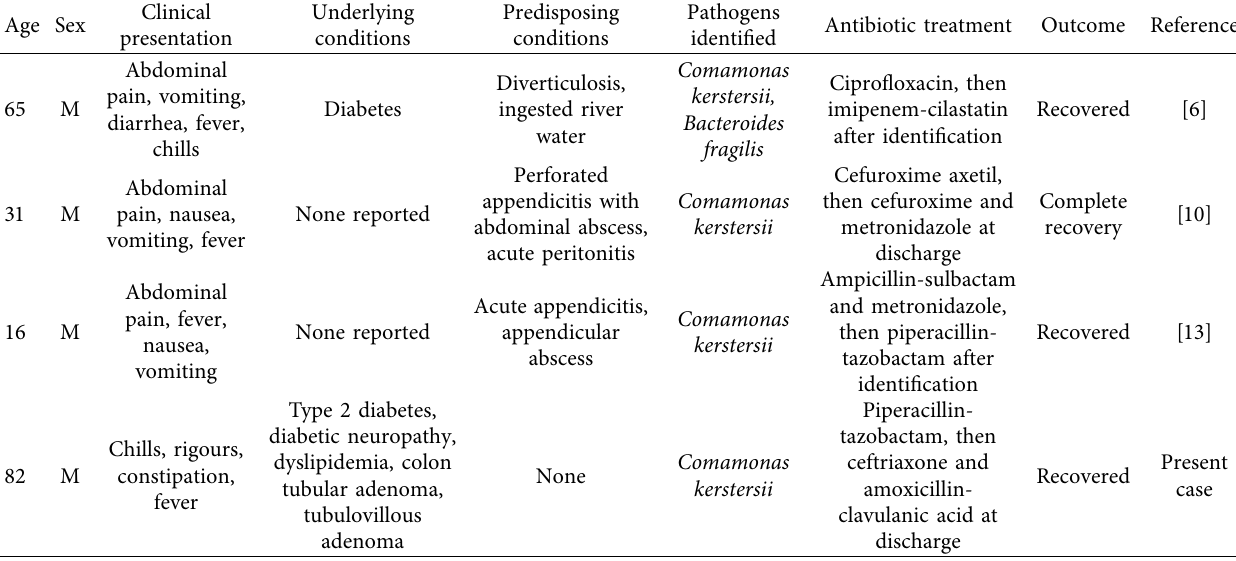
Table 2: Clinical and microbiologic characteristics of Comamonas kerstersii bacteremia in